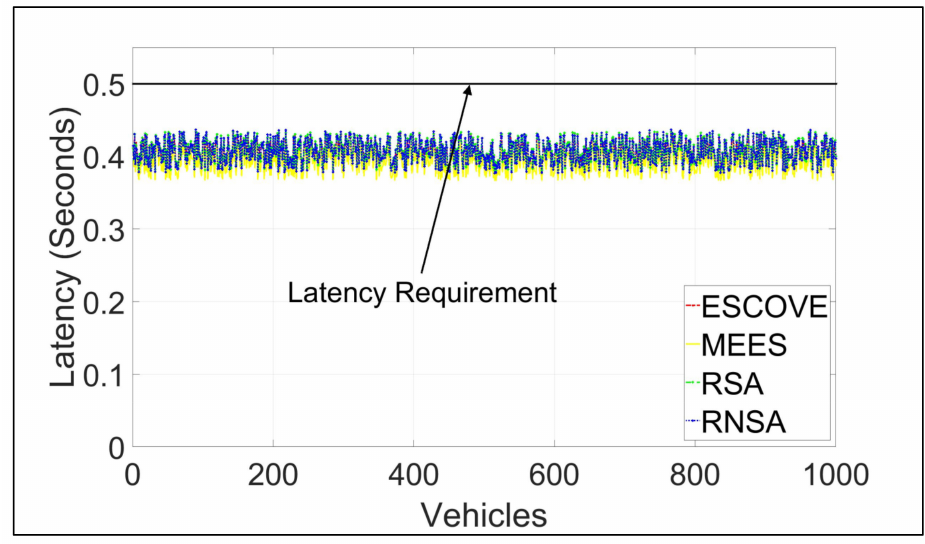
Figure 9. Latencies of requests using ESCOVE, MEES, RSA, and RNSA.